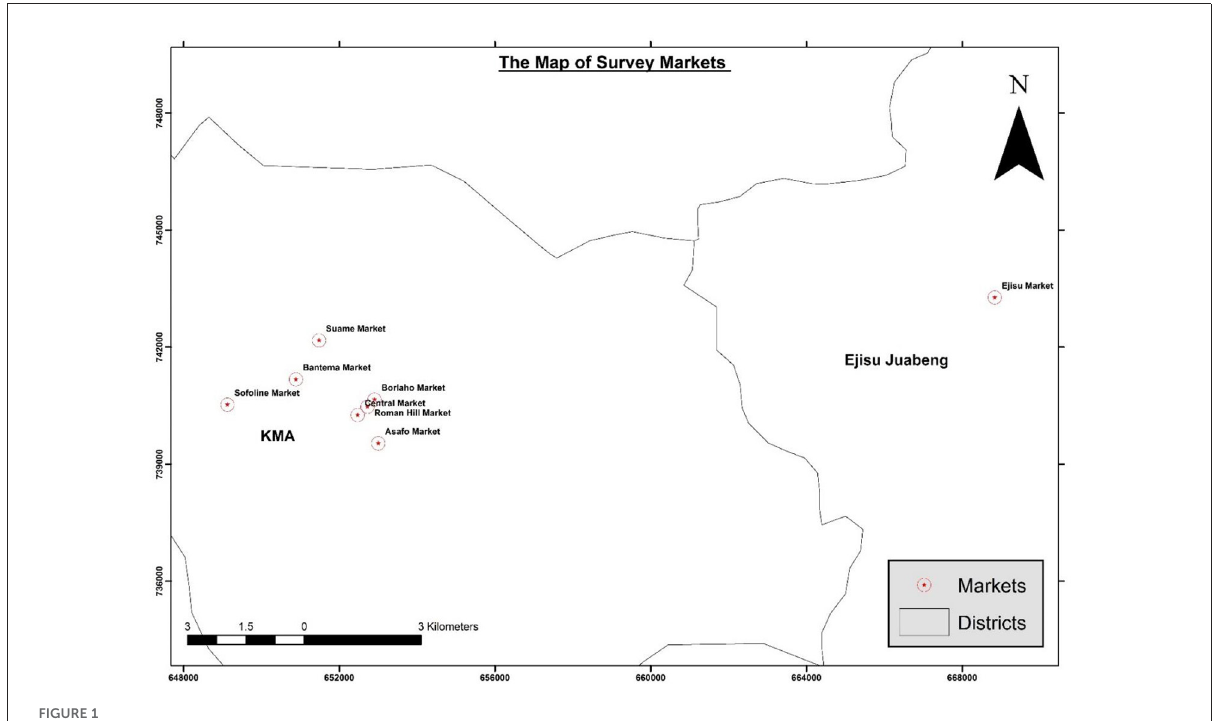
FIGURE1 The map of the markets